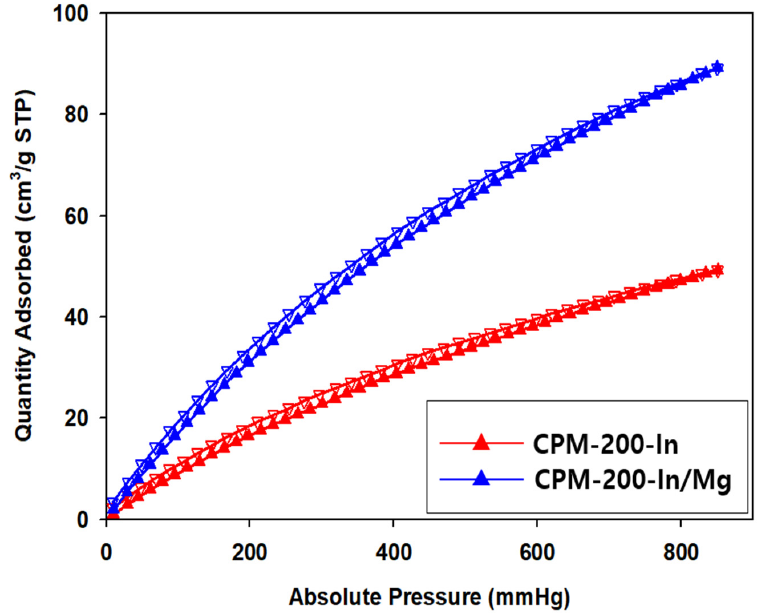
Figure 7. CO 2 adsorption-desorption analysis of CPM-200-In and CPM-200-In/Mg.